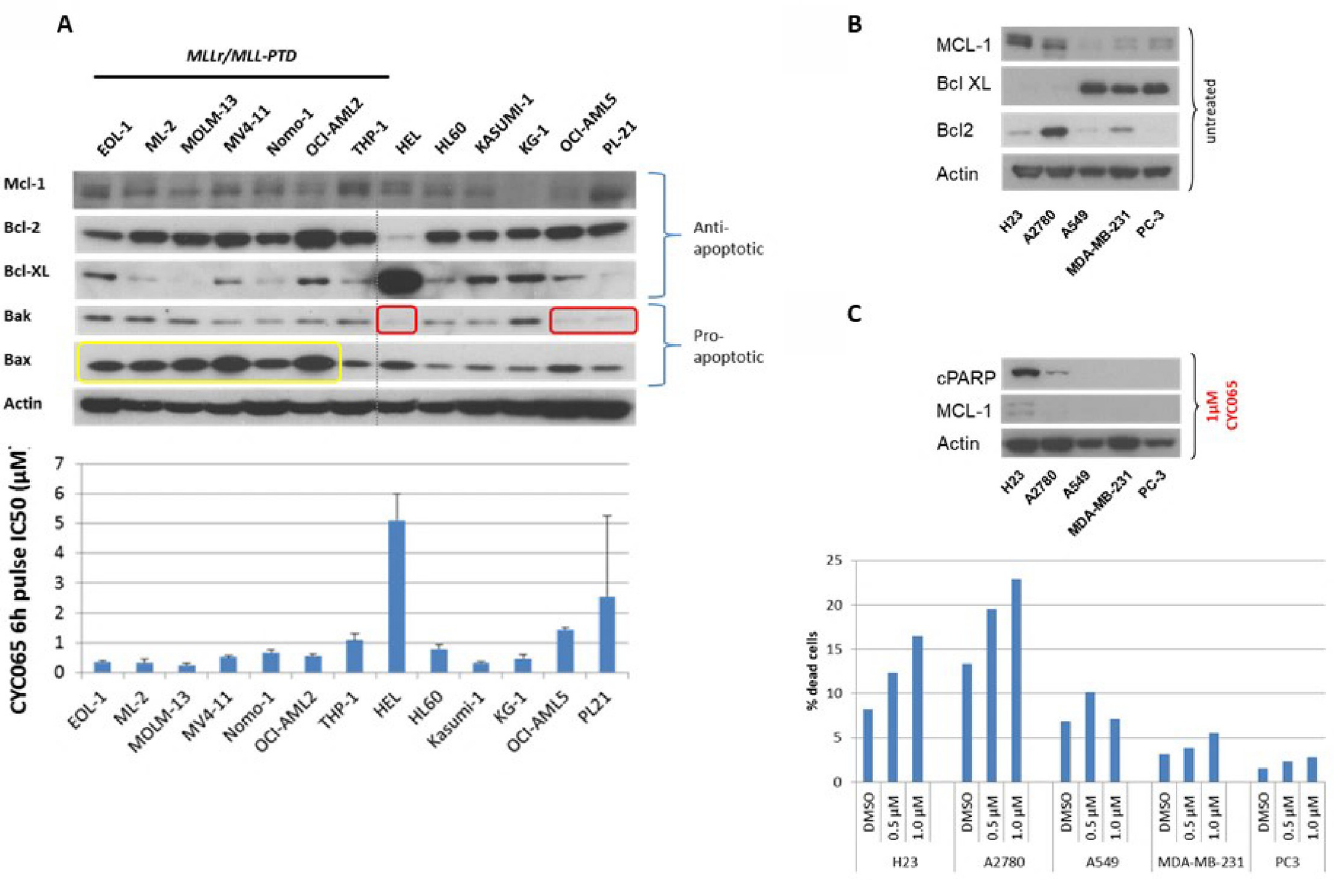
Fig 5. BCL2 family member expression correlates with sensitivity to fadraciclib (CYC065). A. Steady state levels of BCL2 family members in the human AML cell line panel. Lysates were prepared from actively proliferating cell lines and the expression of various BCL2 family members was examined by Western blotting. B. Steady state levels of BCL2 family members in selected solid tumour cell lines. C. Induction of cell death. Cleavage of PARP was measured by Western blotting (upper) and % dead cells was assessed by Viacount viability assay at 6 h and 24 h.